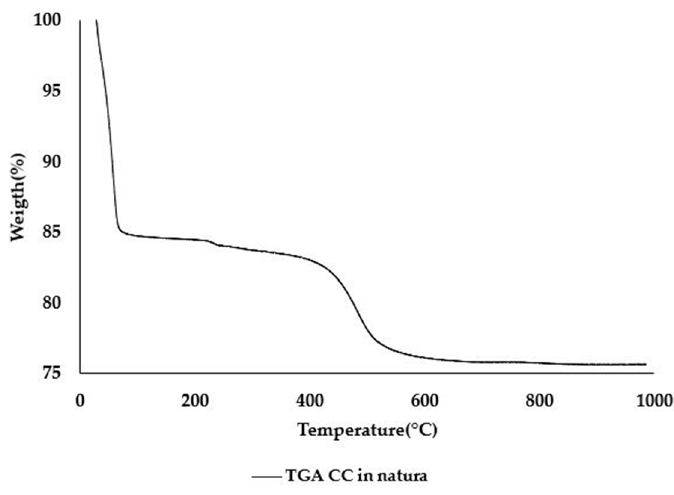
Figure 1. Natural CC TGA curve .